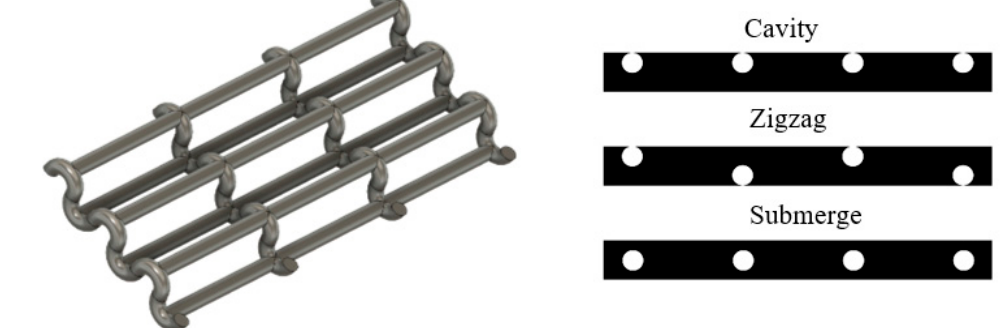
Figure 1. A view of the morphology of the modified feed spacer.